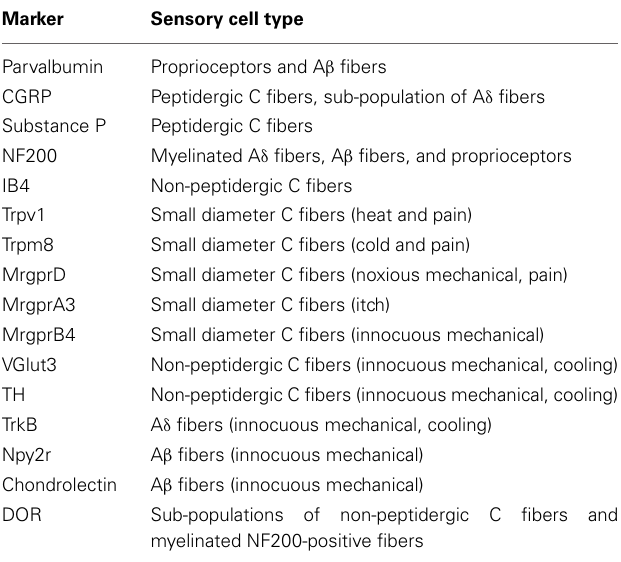
Table 1 | Somatosensory cell type